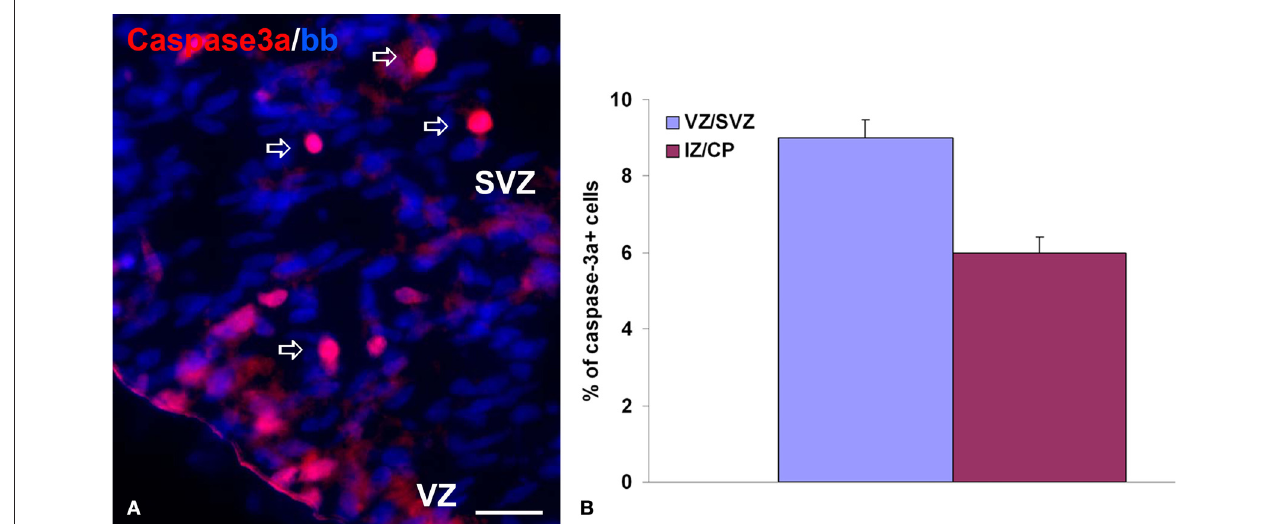
(B) Proportion of caspase-3a + cells in all bisbenzamide-labeled nuclei in the VZ/ SVZ and intermediate zone/cortical plate (IZ/CP) of 19-week-old human